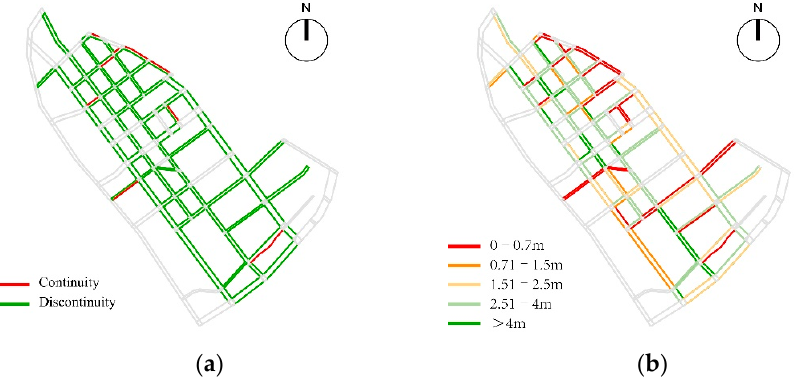
Figure 10. The analysis of pedestrian space accessibility: ( a ) Spatial Connectivity; ( b ) Effective Walking Width.